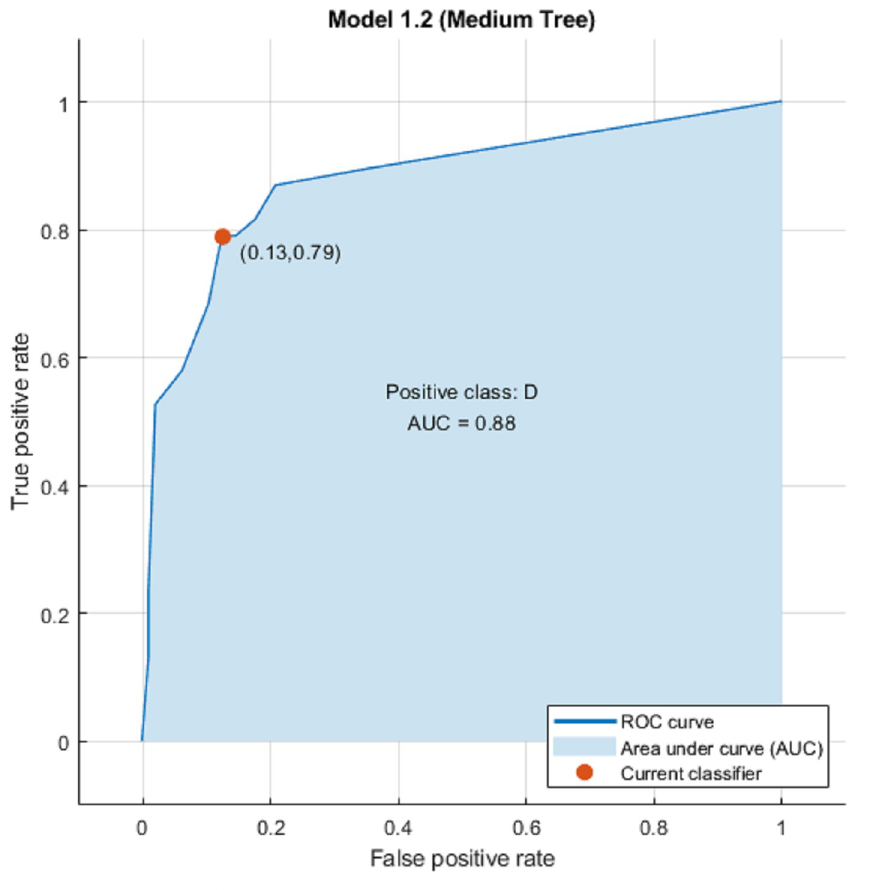
Fig 5. Medium tree model